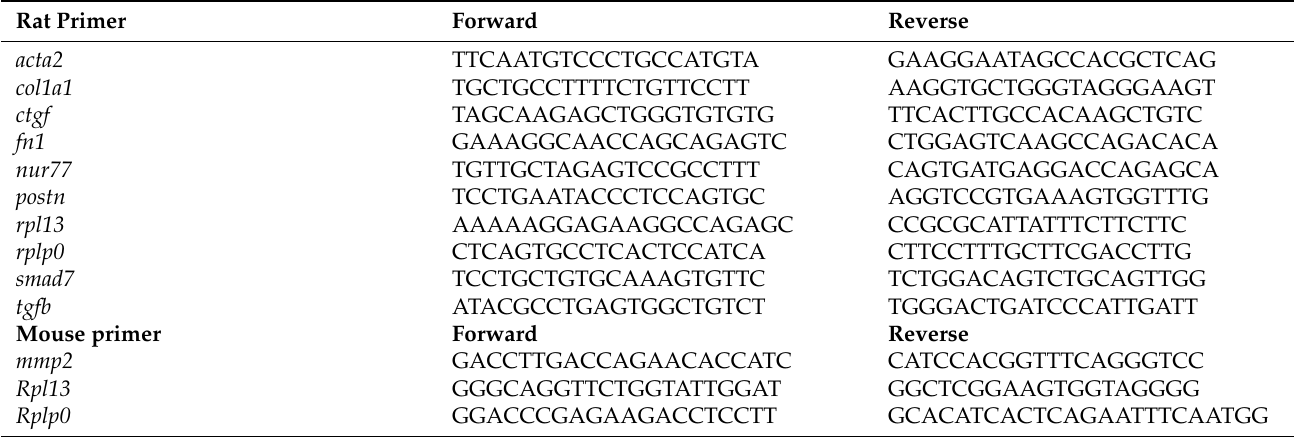
Table 1. Primer sequences. acta2 : α -smooth muscle actin, col1a1 : collagen type 1, ctgf : connective tissue growth factor, fn1 : fibronectin, mmp2 : matrix metalloproteinase 2, postn : periostin, rpl13 : ribosomal protein l13, rplp0 : ribosomal protein p0, tgfb : transforming growth factor— β